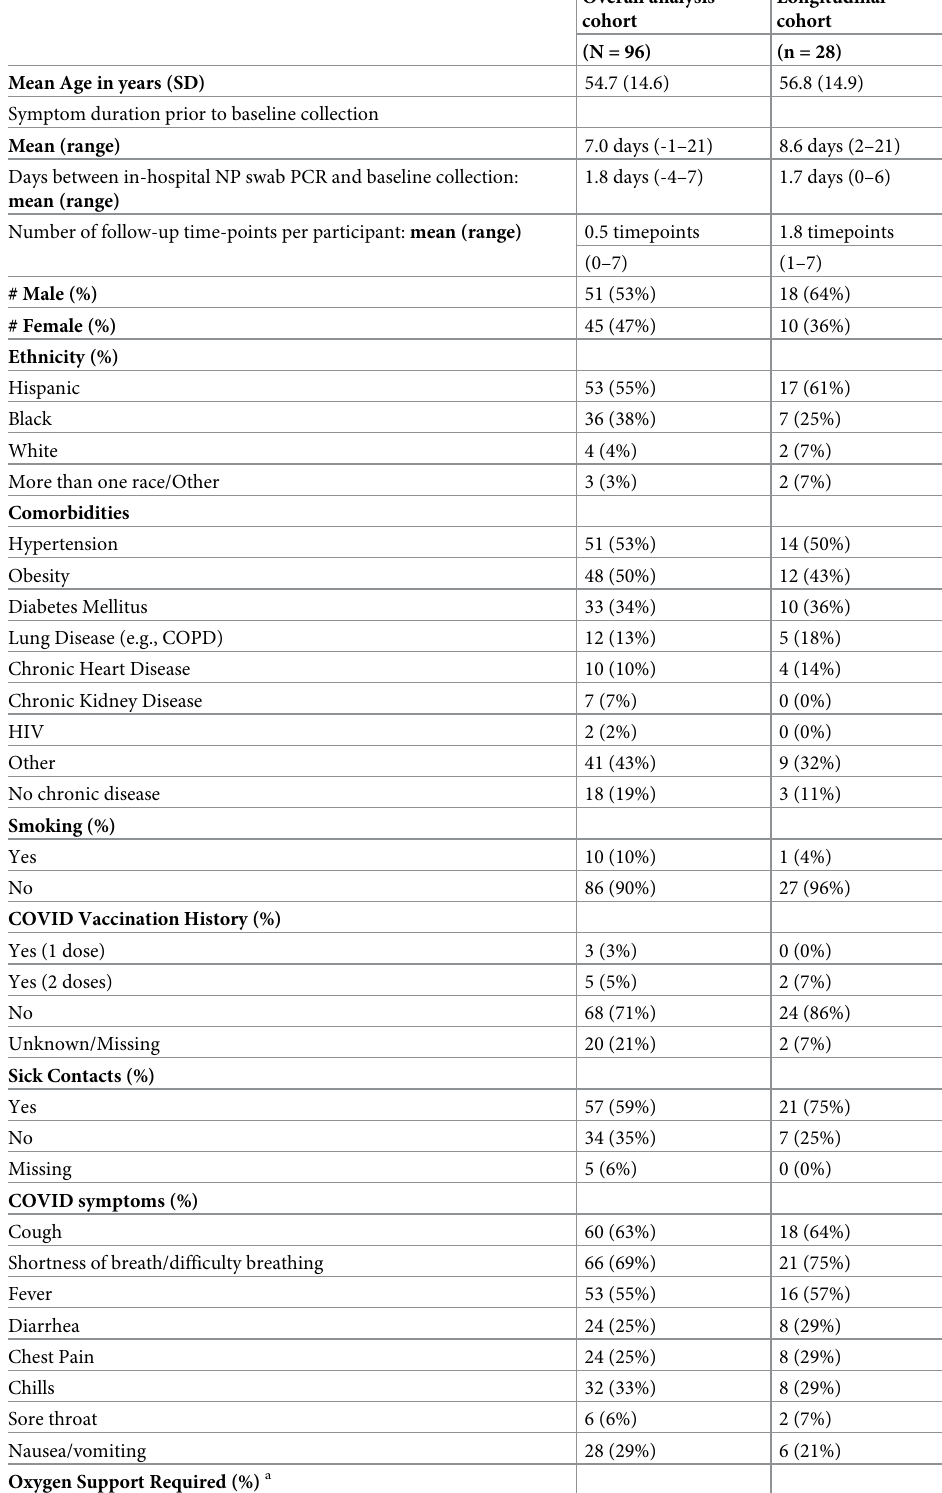
Table 1. Characteristics of participants in the overall and longitudinal